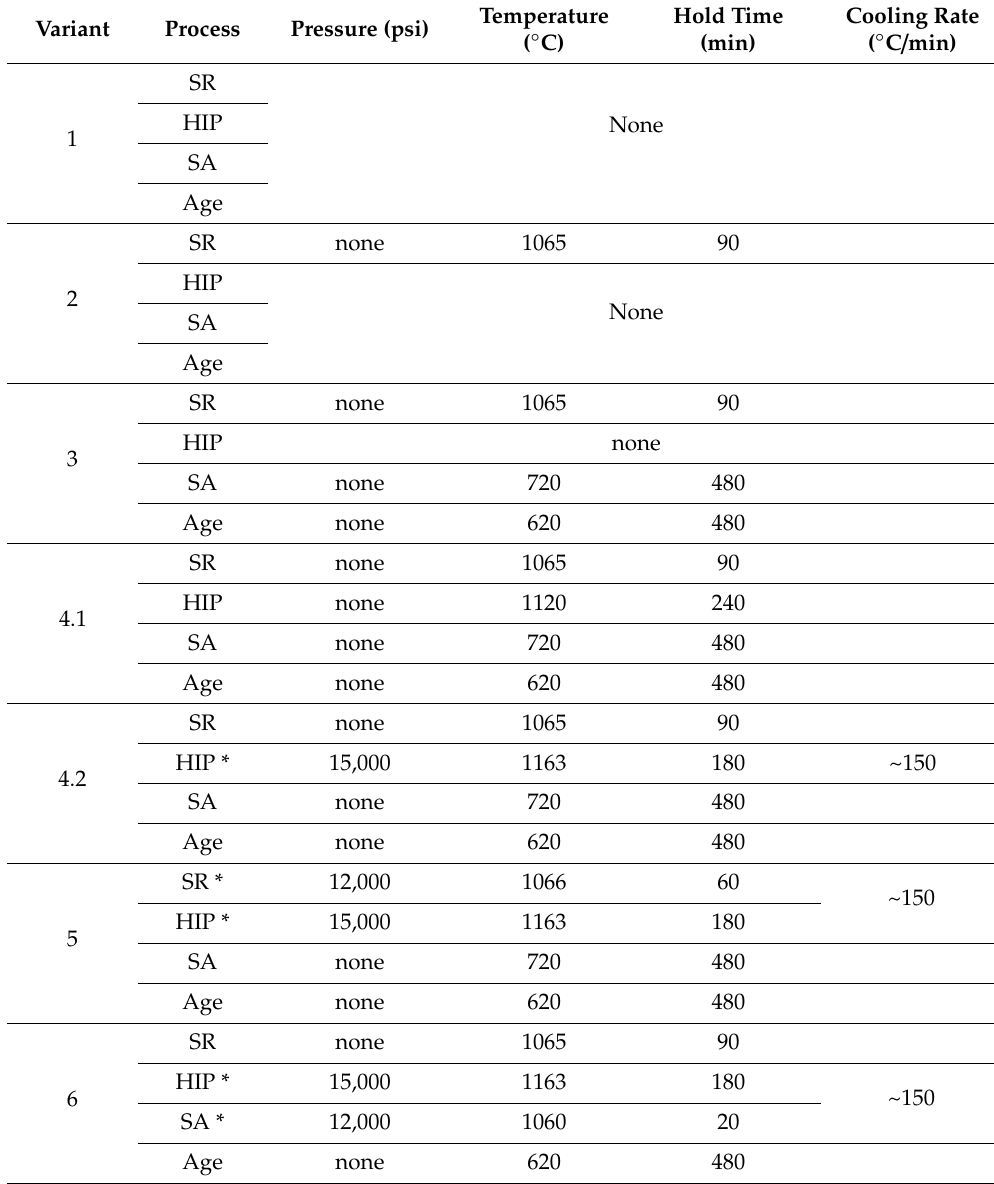
Table 1. Hot Isostatic Pressing and Heat Treatment